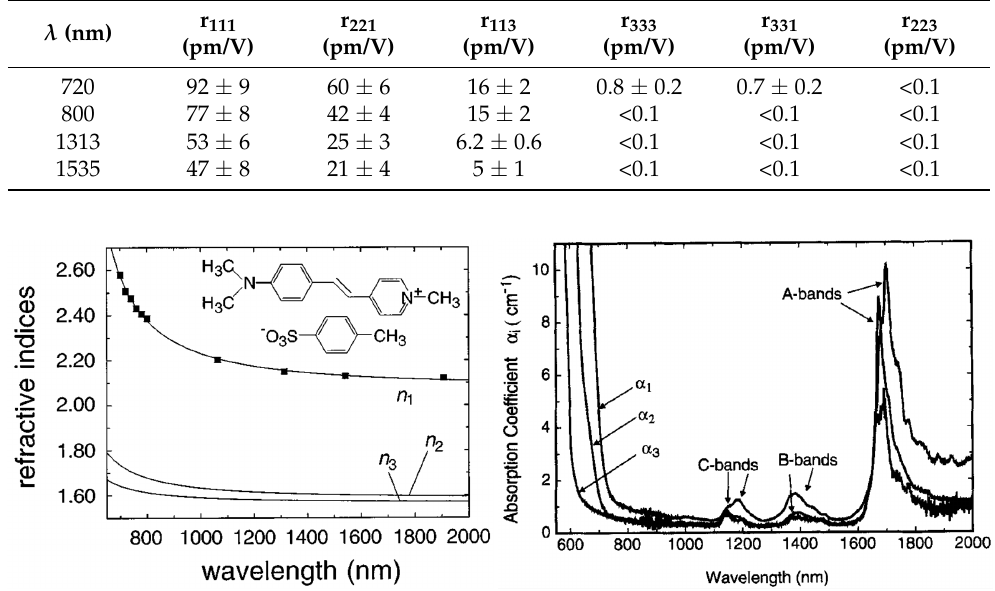
Table 9. Linear electro-optic coefficients of DAST [93].